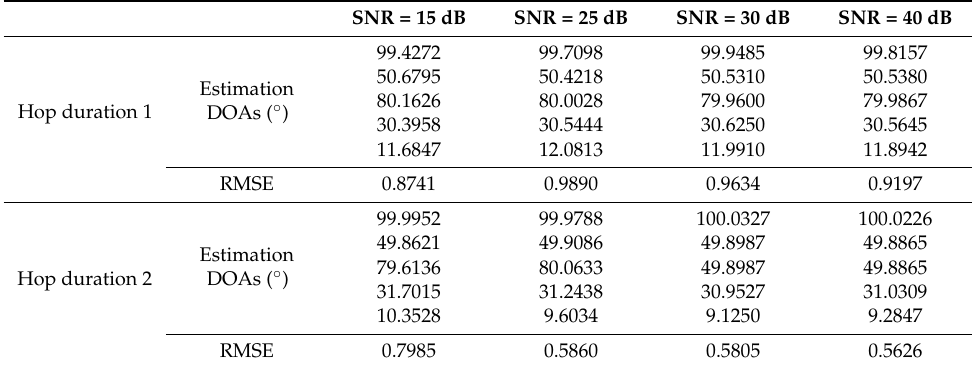
Table 2. The RMSE performance of the proposed